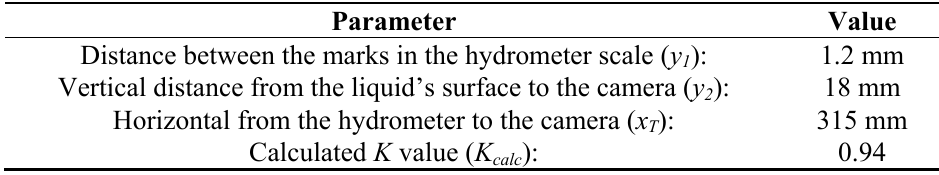
for the high accuracy hydrometer. Table 3. K calc